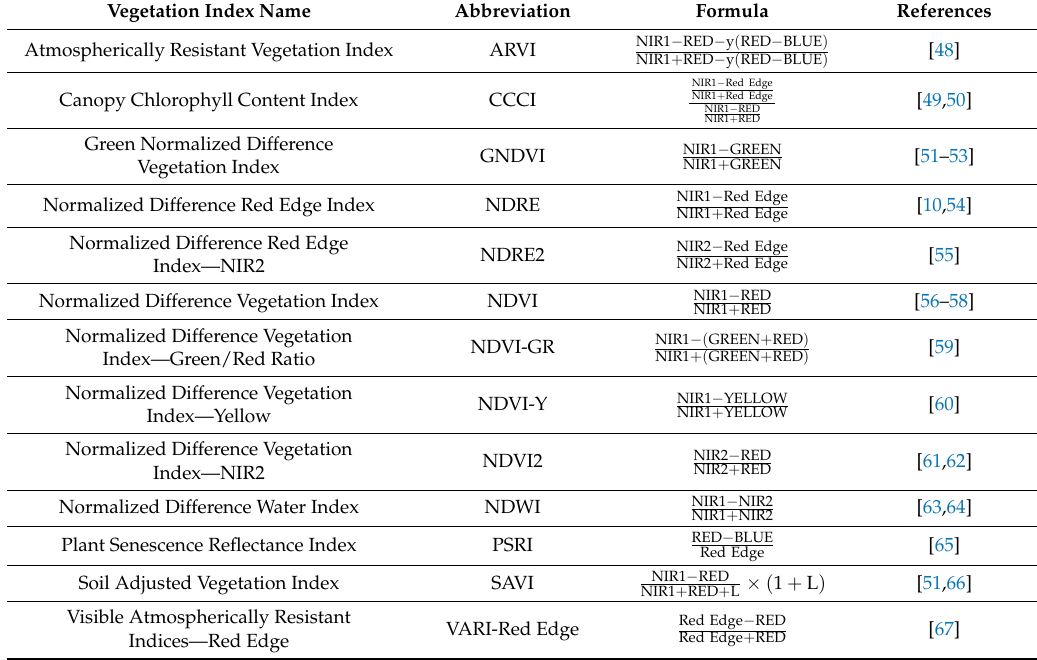
Table 4. Vegetation indices utilized for tree species